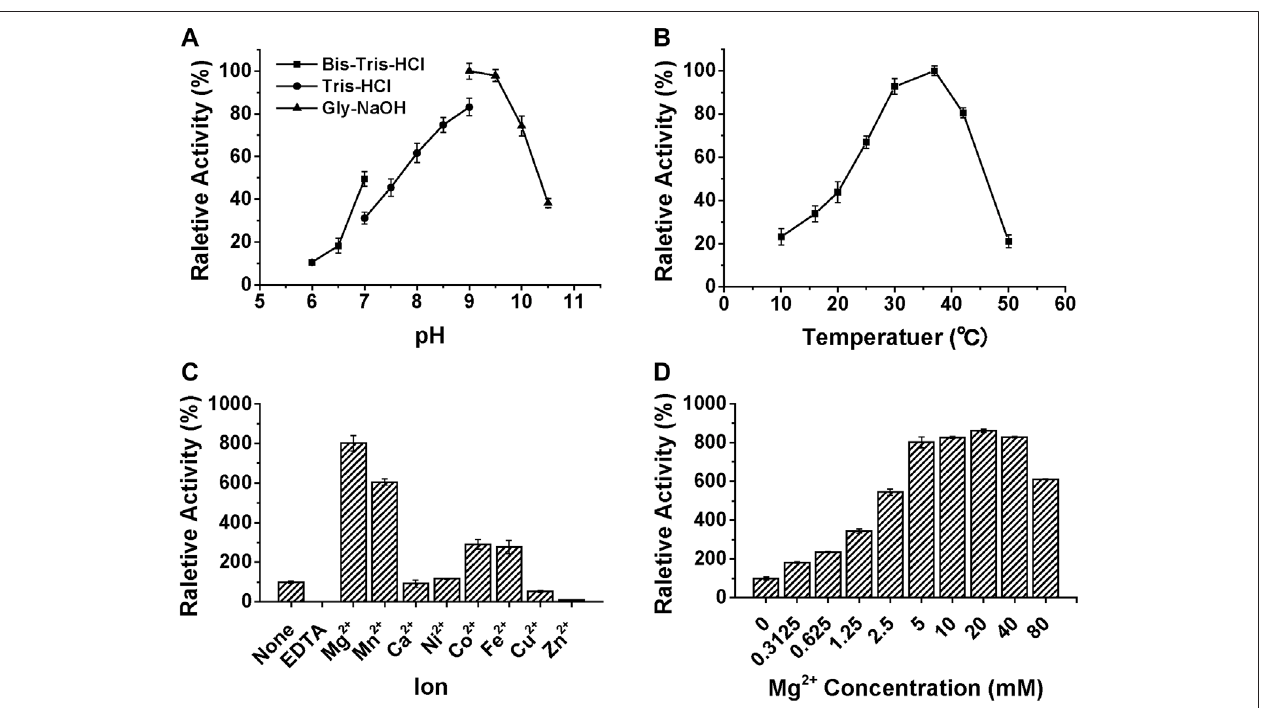
FIGURE 3 | The in fl uences of pH (A) , temperature (B) , ions (C) , and Mg 2+ concentration (D) on the relative activity of WciN to catalyze galactosylation of Glc α -PP- (CH 2 ) 11 -OPh 1 with